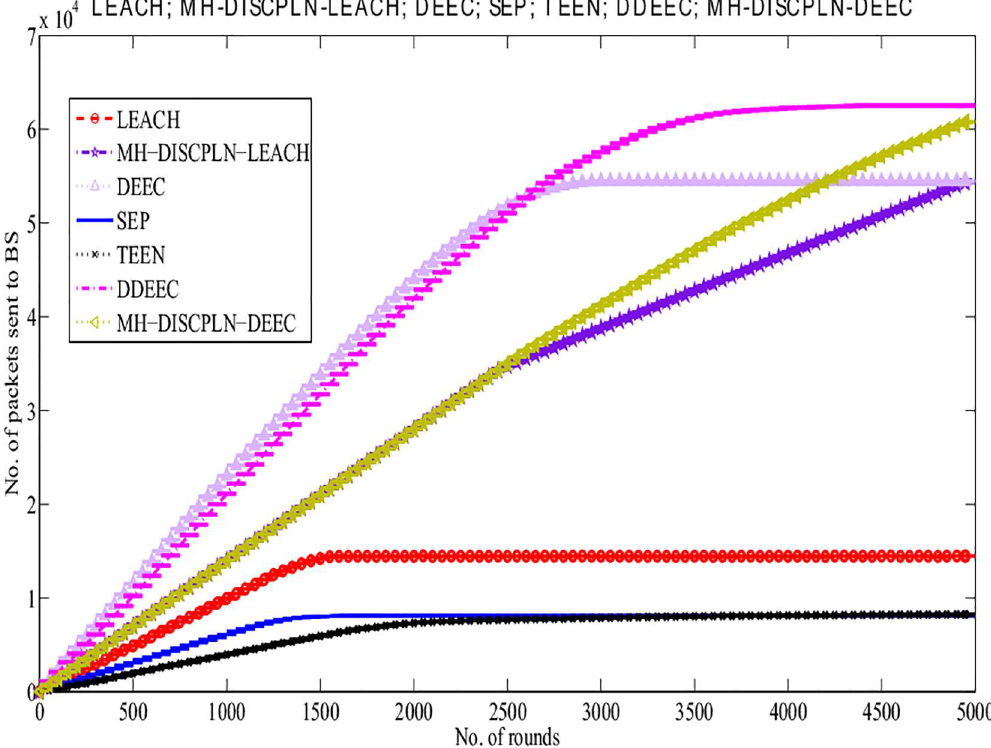
Fig 12. Performance comparison basedon throughputfor multi-hop communication.